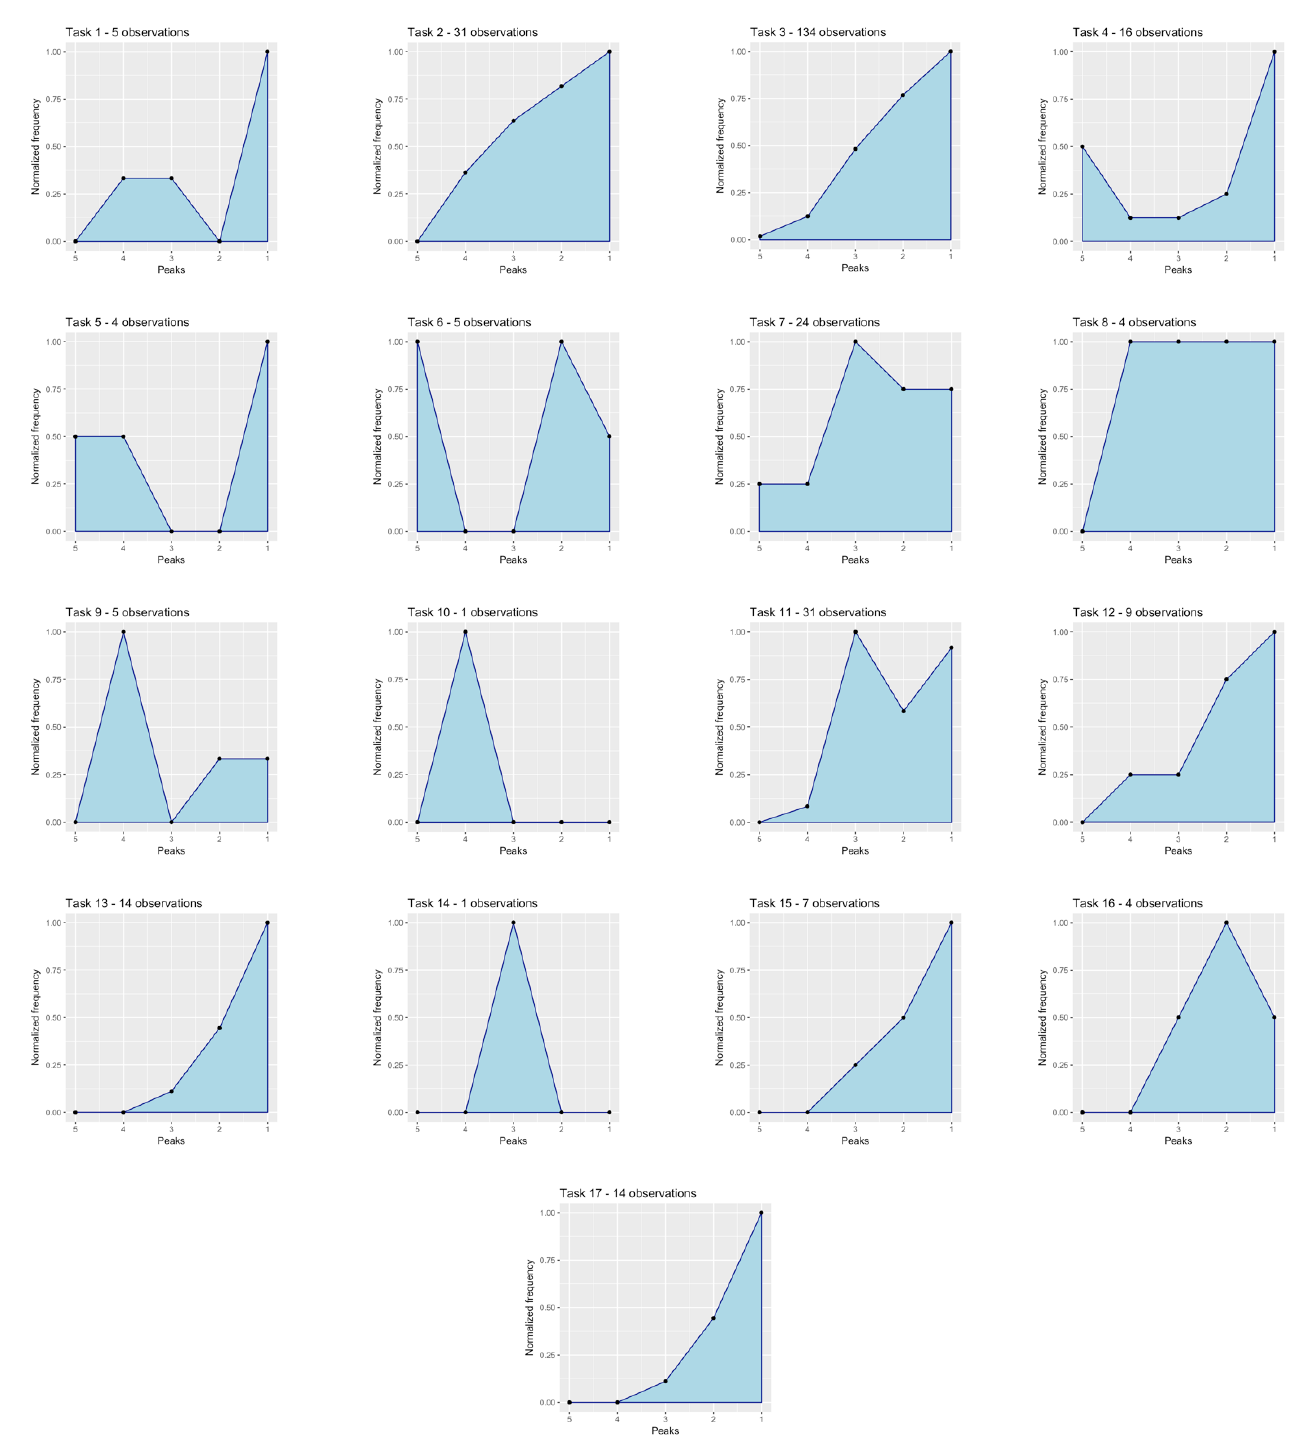
Fig. 7. Task learning curves computed for each of the tasks. The x-axis represents the presence of the task in the cluster of the respective number of EDPs. The y-axis shows the normalized frequency for the respective task in the